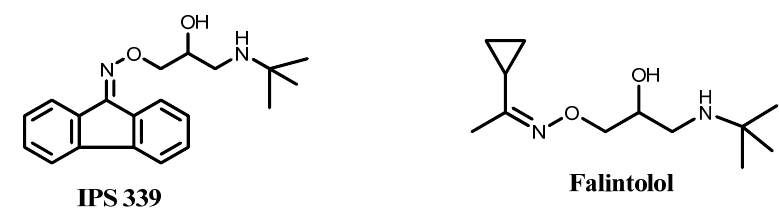
Figure 1. Chemical structures of IPS 339 and